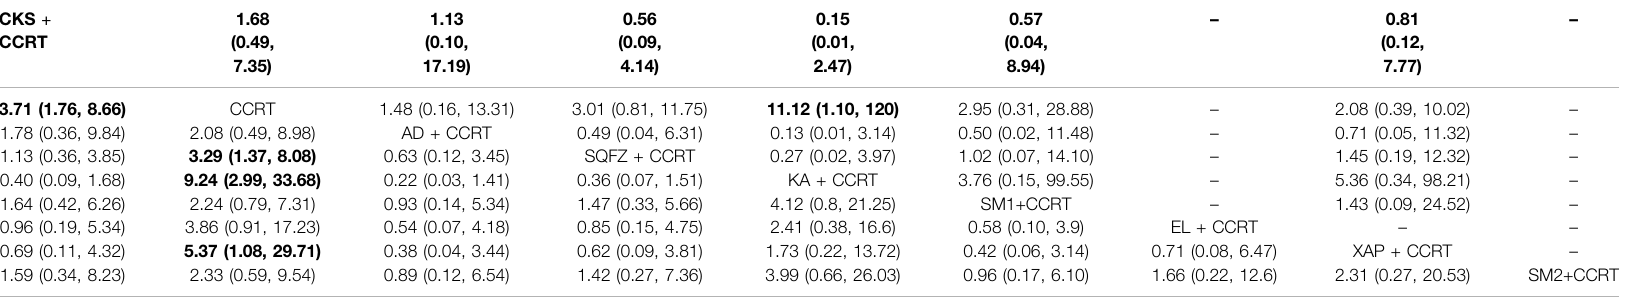
TABLE 4 | Results of the NMA of thrombopenia (upper-right quarter) and leukopenia (lower-left quarter).